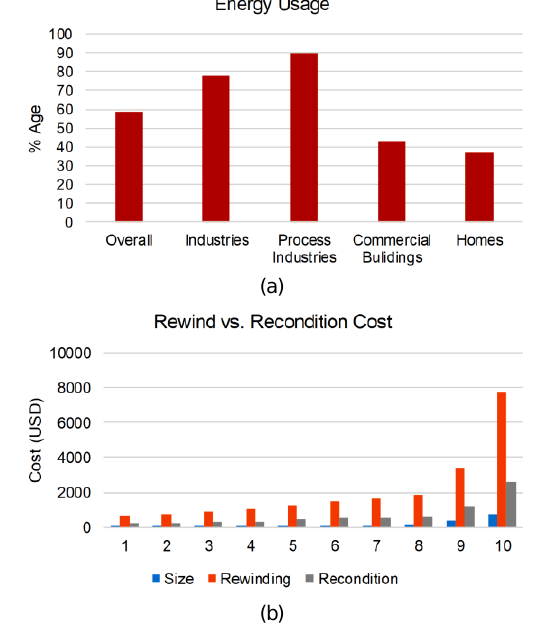
Fig. 1. Worldwide energy usage by electrical machines (a), and a comparison of rewind vs. recondition costs